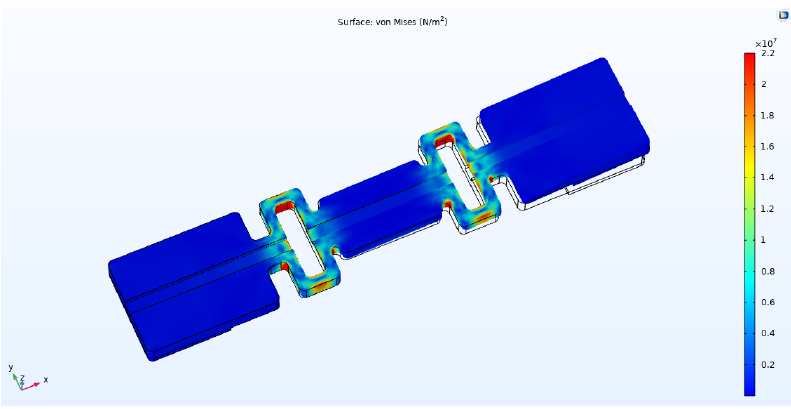
Figure 3. Stress contour plots of PLA-AE-FBG1.